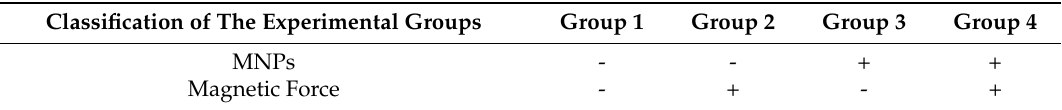
Table 1. Classification of experimental groups depending on the presence of MNPs or magnetic force loading. Classification of The Experimental Groups Group 1 Group 2 Group 3 Group 4 MNPs - - + + Magnetic Force - + - +